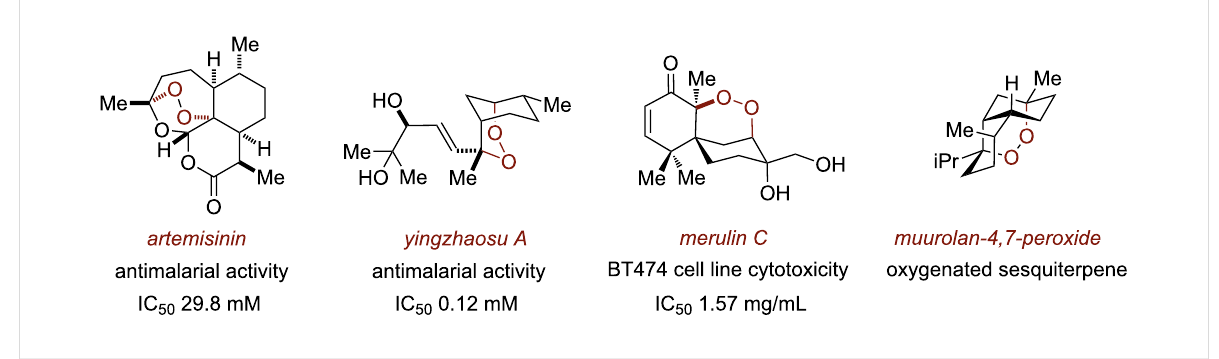
Figure 1: Selected examples of endoperoxide-containing natural products.